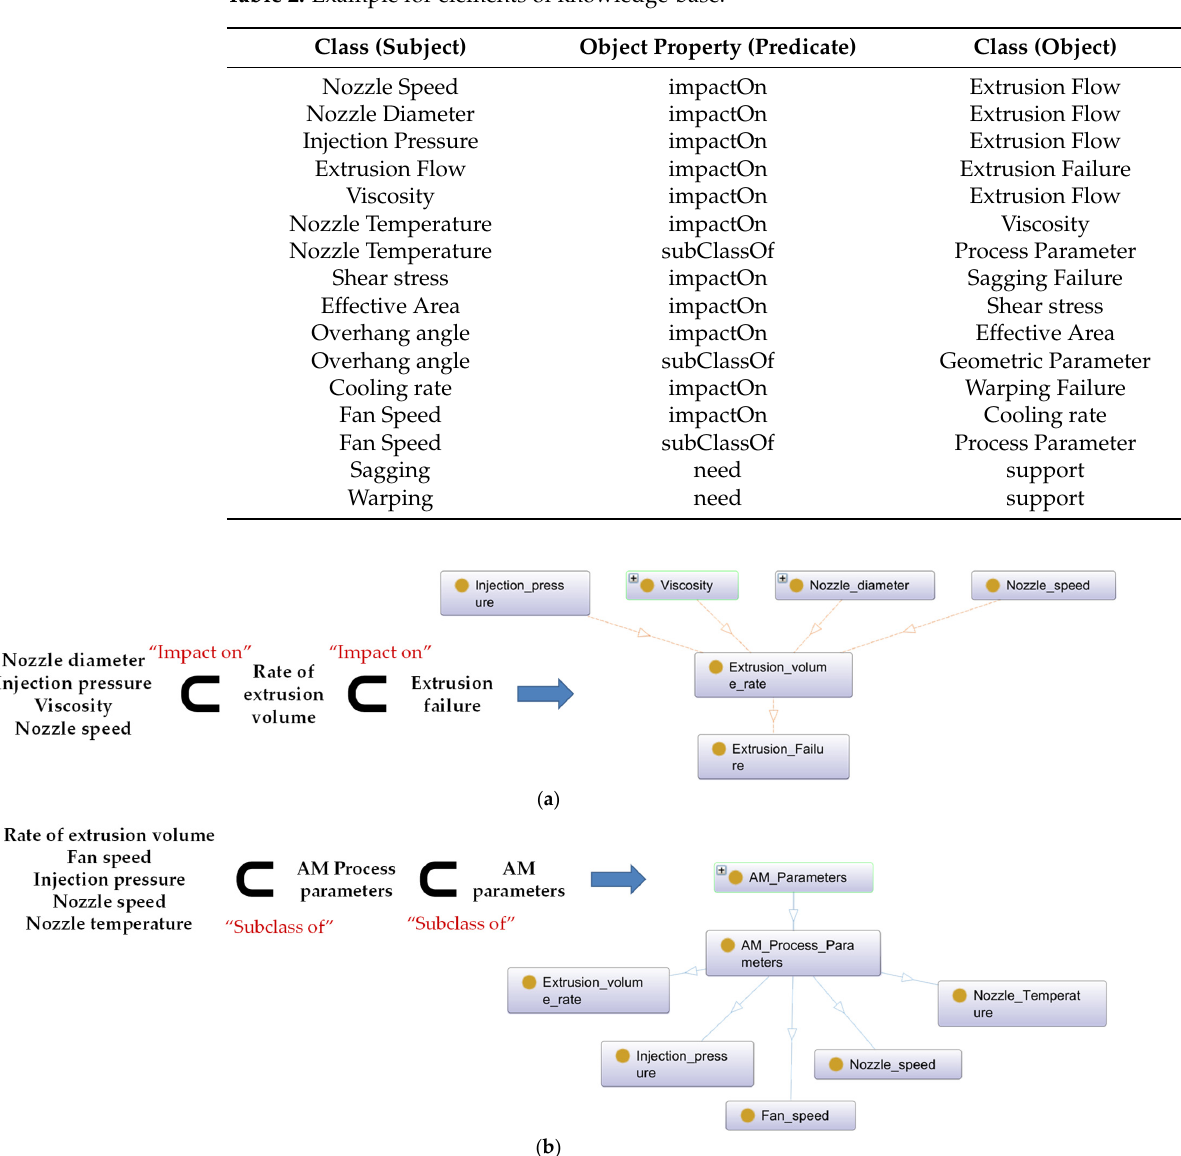
Figure 4. Schematic diagram for constructing AM ontology: ( a ) Implementation of “Impact on”; ( b ) Implementation of “Subclass of” in Prot é g é